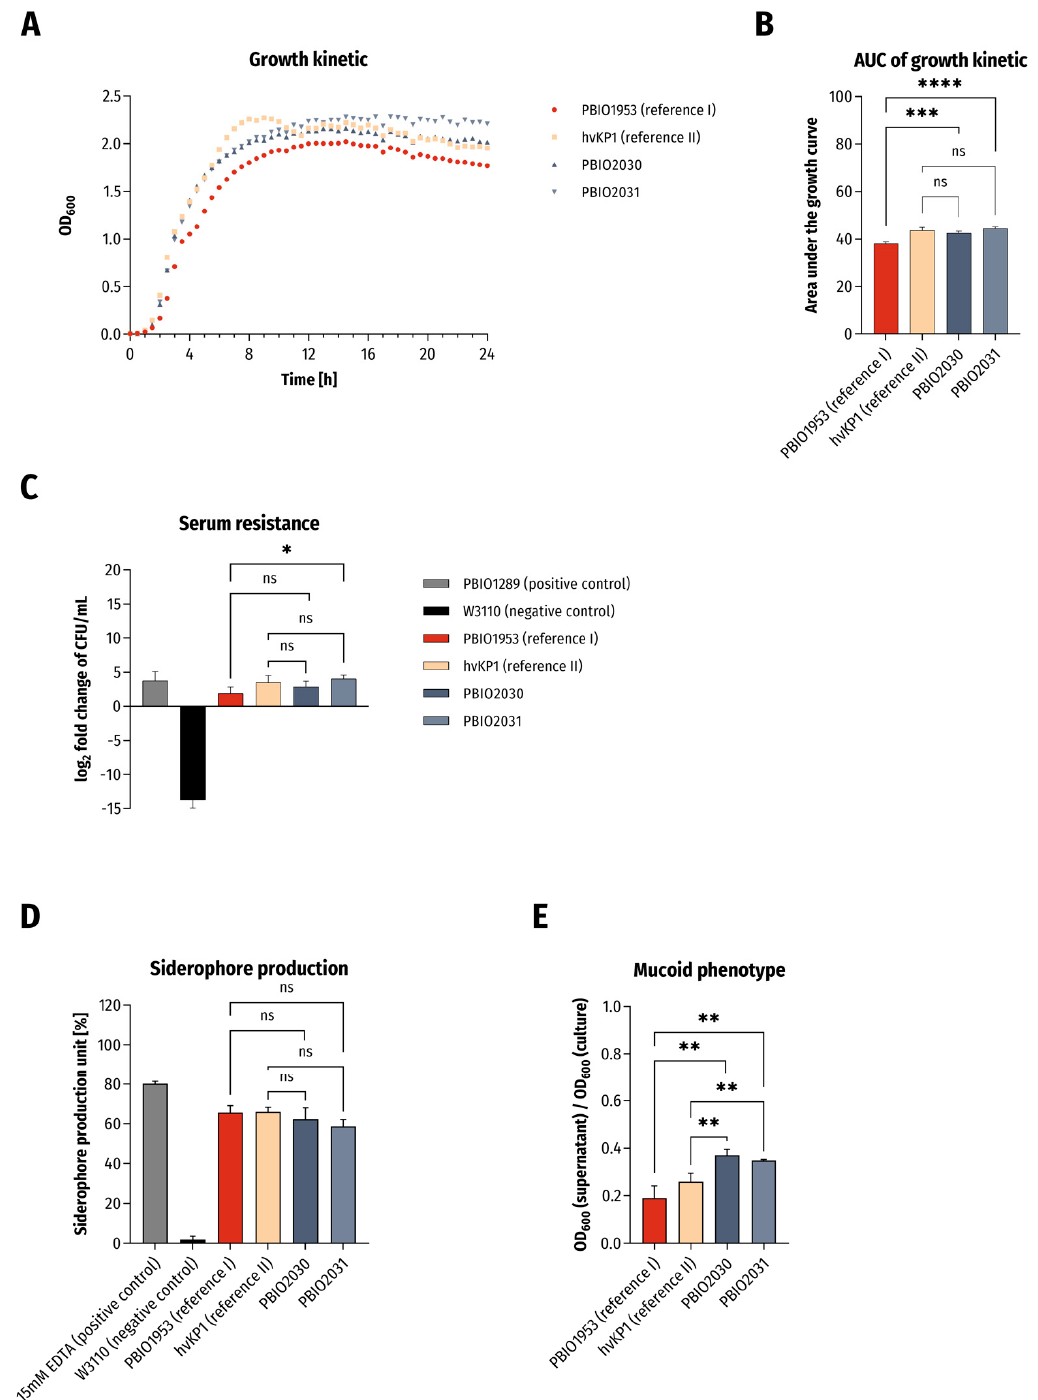
Figure 1. Results of phenotypic experiments. ( A ) Growth kinetics in LB broth and ( B ) statistical comparison of area under the curve (AUC) of growth curves. The results are given as mean values and standard deviation of AUCs. ( C ) Survival in 50% human serum. The results are given as mean values and standard deviation of log 2 fold change of CFU/mL after 4 h of incubation in serum. ( D ) Siderophore production ability ( n = 3). The results are given as mean values of siderophore production unit and standard deviation. ( E ) Determination of mucoid phenotype using sedimentation assay ( n = 3). The results are given as mean ratios of OD 600 of supernatant after centrifugation at 1000 × g for 5 min and OD 600 of the overnight culture and standard deviation. For all results the clinical isolates were compared to PBIO1953 ( K. pneumoniae , ST307) and hvKP1 (archetypical hypervirulent K. pneumoniae ) in variance analyses (one-way ANOVA with Dunnett’s multiple comparison post-hoc test). The significance level ( p value) is as follows: ns not significant, * p < 0.05; ** p < 0.01; *** p < 0.001; **** p <